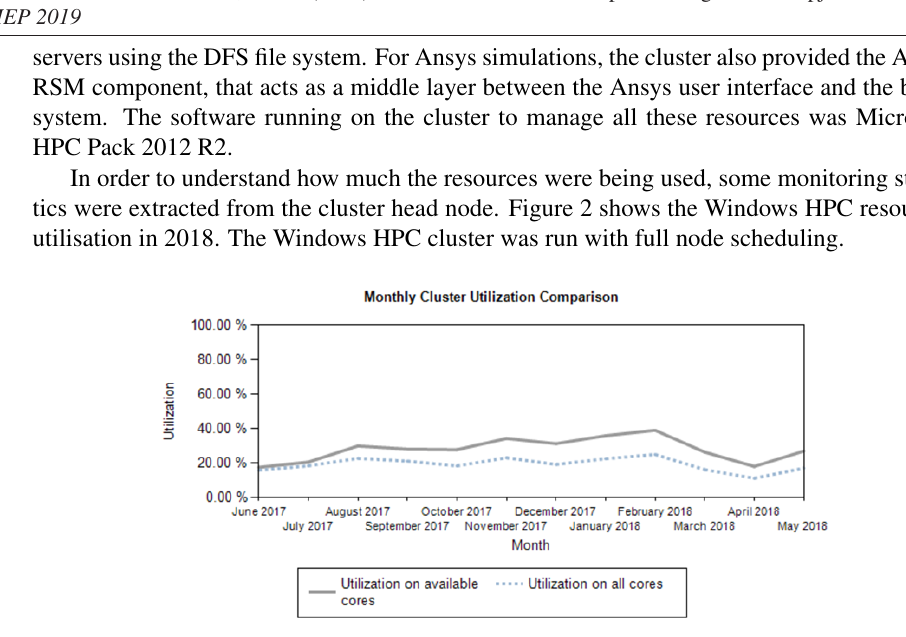
Figure 2. Windows HPC cluster usage in